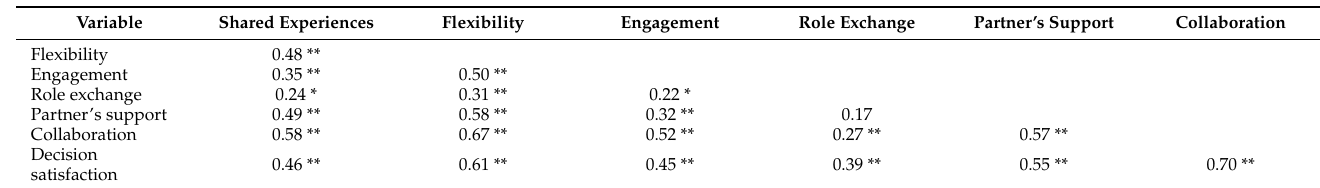
Table 2. Correlations between all variables in the